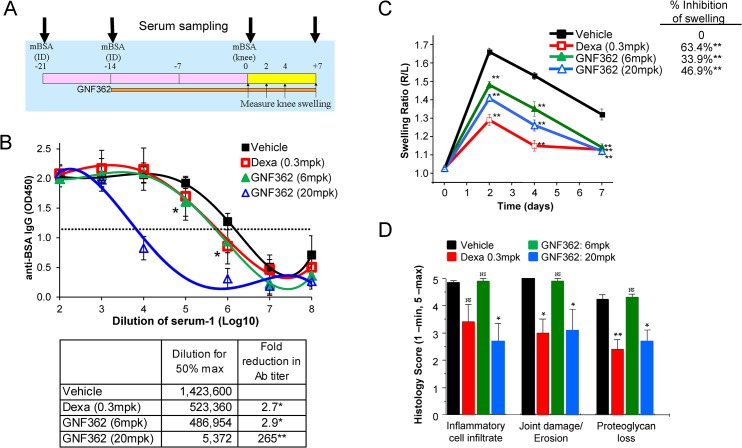
Itpkb inhibitors block rat antigen-induced arthritis.(A) Lewis rats were immunized intra-dermally on Day -21 and -14 with methylated BSA (mBSA), followed by daily oral dosing of GNF362, or dexamethasone (Dex) as a positive control. On Day 0, the rats received an intra-articular injection of mBSA into the right knee joint. (B) Serum was sampled on Day +7, and IgG antibody titers to mBSA were determined by ELISA. The antibody titers were calculated by determining the average dilution at which half-maximal absorbance is detected after subtraction of background. Fold reduction in antibody titer over vehicle is shown in the table. Data shown is one representative experiment. (C) The diameters of the right and left knees were measured on Days 0, 2, 4, and 7, and the ratio of right over left knee diameters (R/L) is shown. (D) Histological analysis of the knee joint was performed blindly and scored on a 5-point scale at the termination of the study. Data shown is one representative experiment. *, P < 0.05; **, P < 0.01.